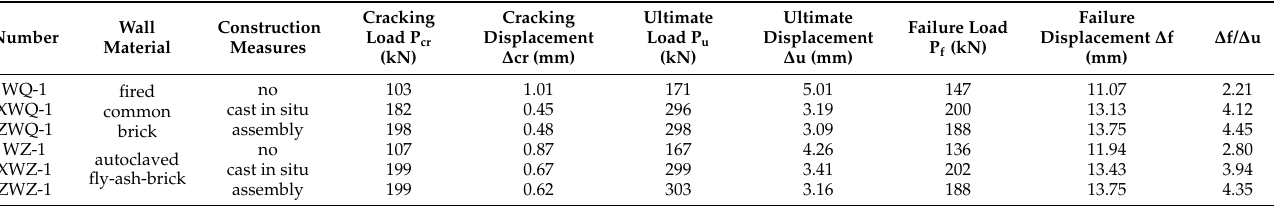
Table 5. Bearing capacity values of the